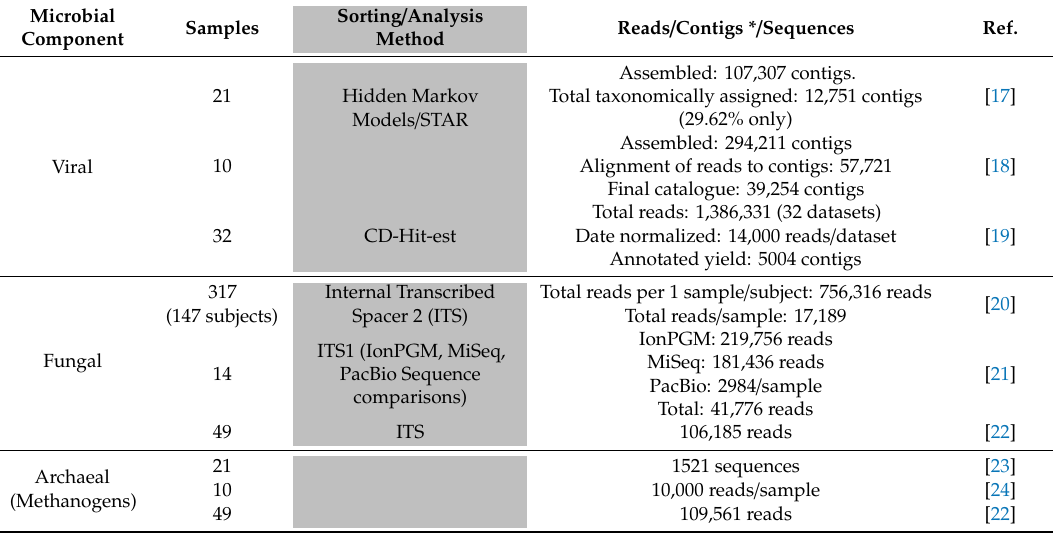
Table 1. Summary of a few significant clinical studies on the viral, fungal, and archaeal microbiomes. Microbial Sorting / Analysis Samples Reads / Contigs * / Component Method